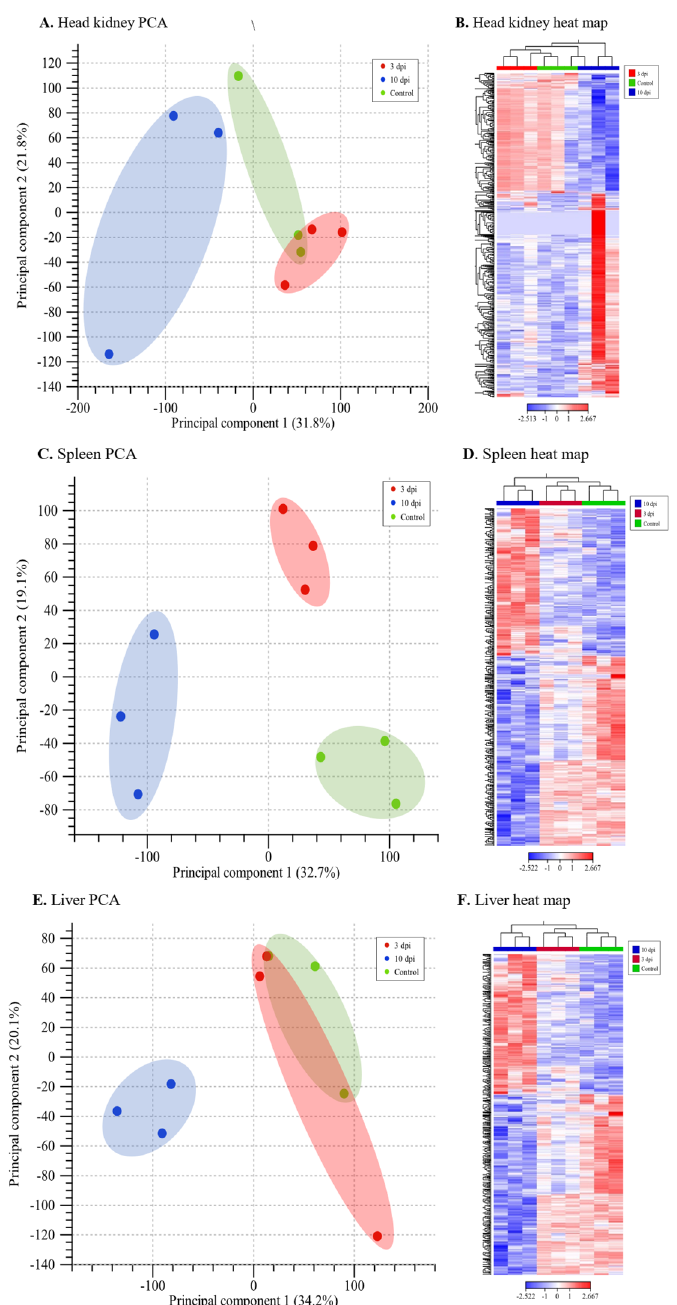
Figure 3. Clusterization of gene expression profile in different lumpfish organs infected A. salmonicida . ( A ). Principal component analysis (PCA) of lumpfish head-kidney infected with A. salmonicida, green dot represents three control samples, red dot represents three 3 dpi samples, blue dot represents three 10 dpi samples; ( B ) . Heatmap of lumpfish head-kidney infected with A. salmonicida ; ( C ) . PCA of lumpfish spleen infected with A. salmonicida, green dot represents three control samples, red dot represents three 3 dpi samples, blue dot represents three 10 dpi samples; ( D ) . Heat map of lumpfish spleen infected with A. salmonicida ; ( E ) . PCA of lumpfish liver infected with A. salmonicida, green dot represents three control samples, red dot represents three 3 dpi samples, blue dot represents three 10 dpi samples; ( F ) . Heat map of lumpfish liver and liver infected with A. salmonicida .